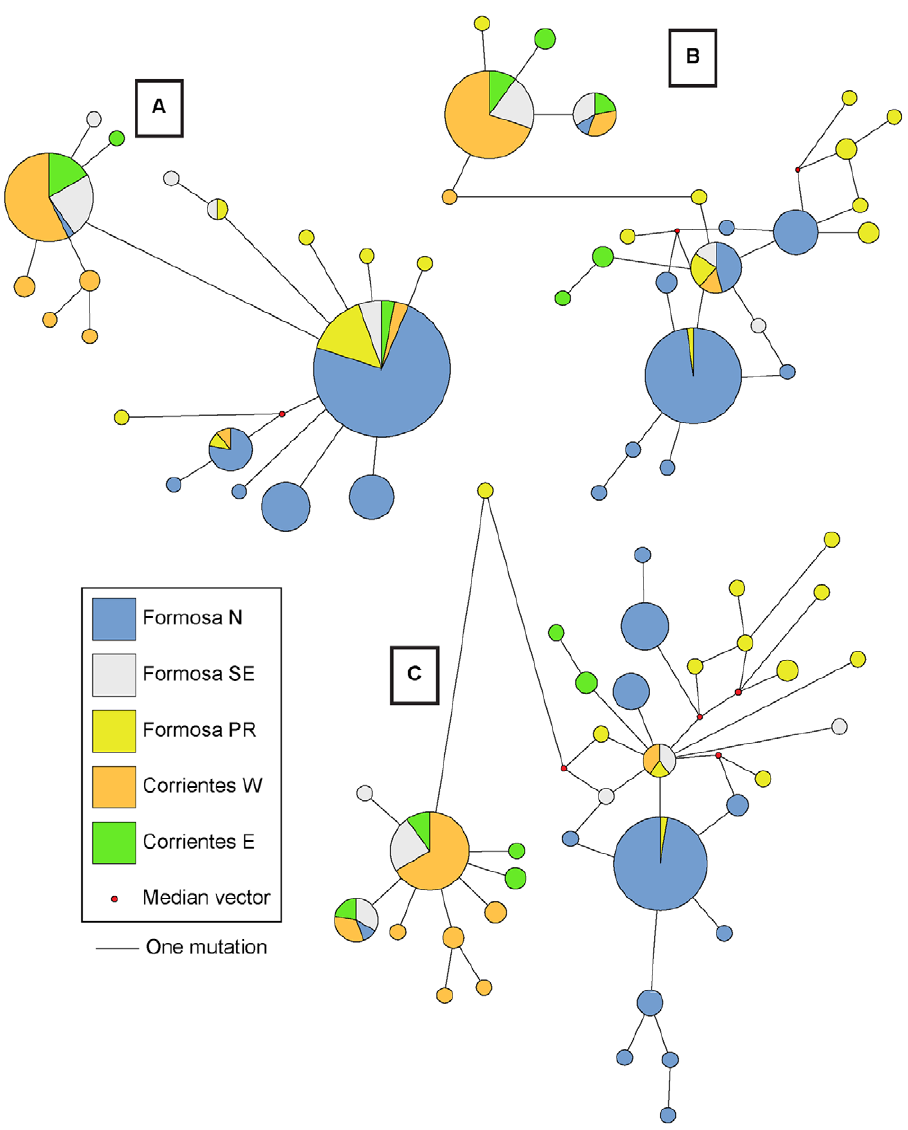
Figure 2. Median-joining haplotype networks. A) cyt- b and ND4 concatenated network with 181 individuals (1249 bp). B) control region network representing 143 individuals (652 bp). C) concatenated cyt- b , ND4, and control region median-joining network for 141 individuals (1,901 bp). Distances between haplotypes are proportional to number of mutations and are measured from the edge of each circle for all networks. Size of circle indicates relative abundance of haplotype.